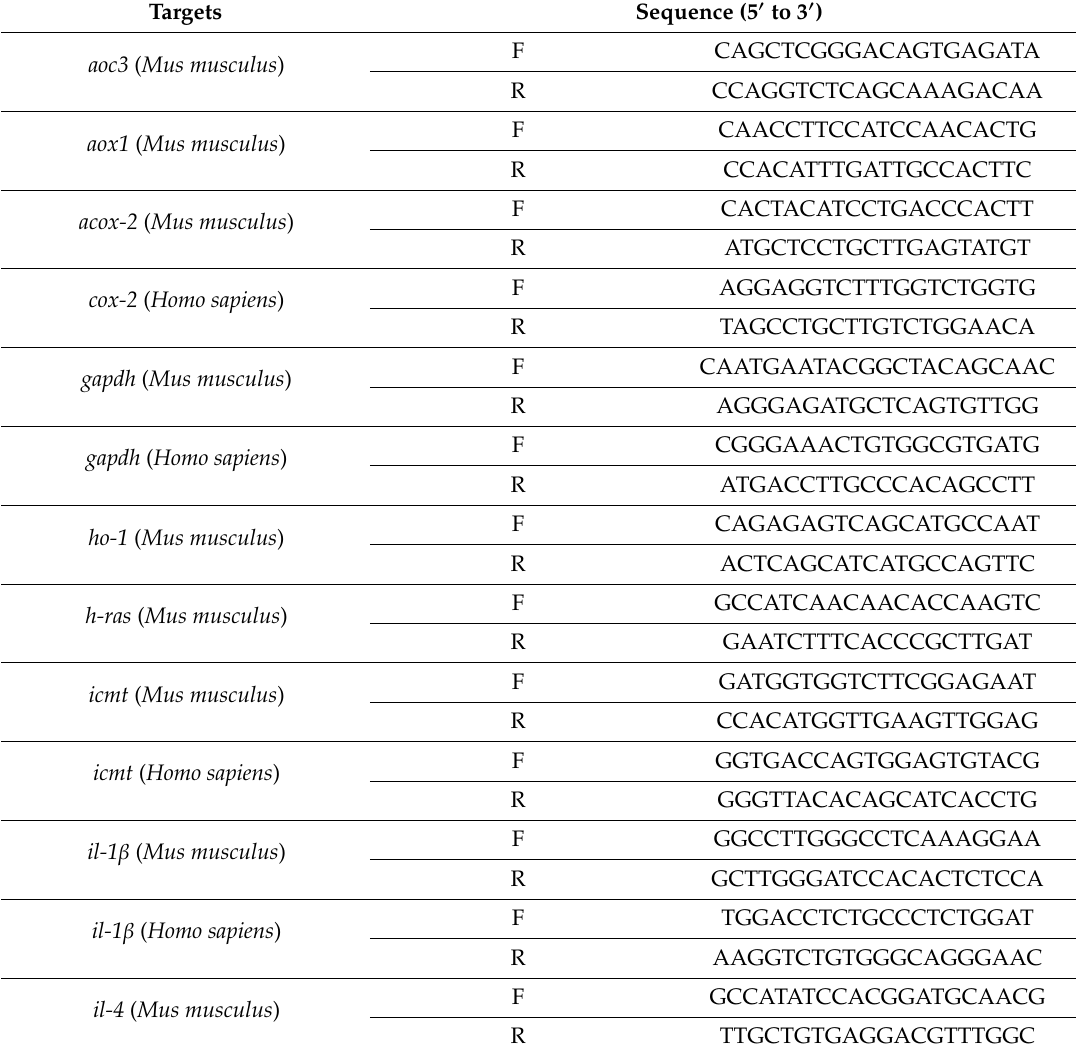
Table 2. Primer sequences used in real time PCR